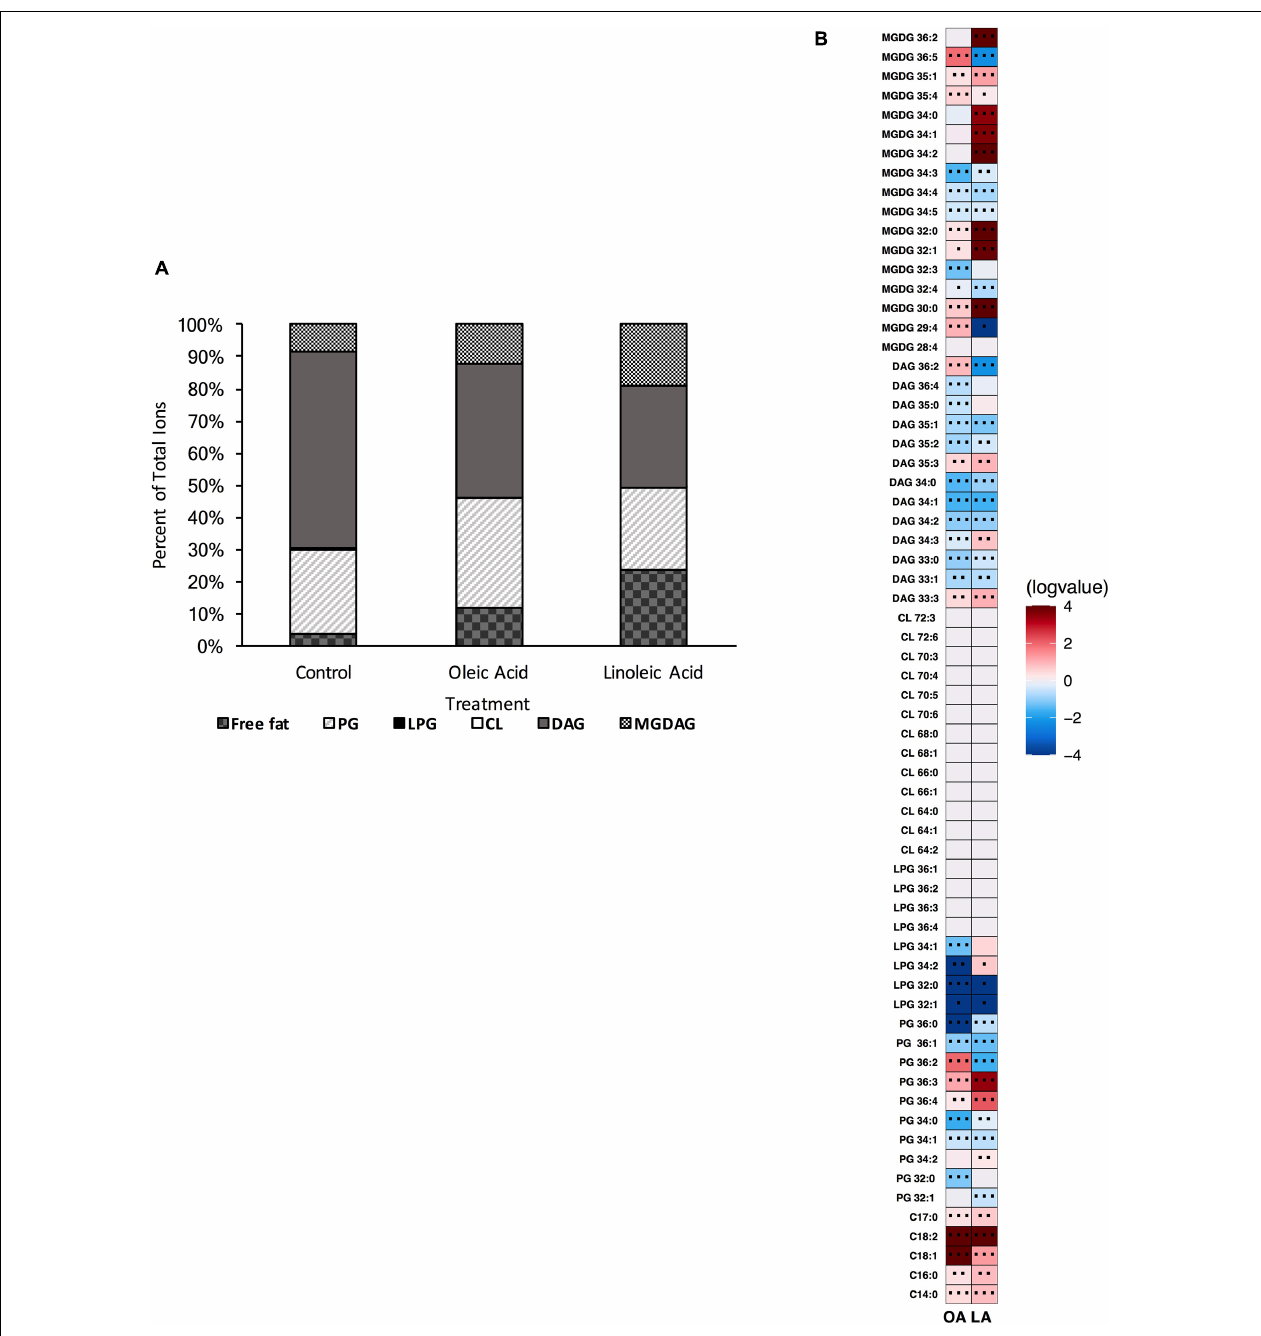
FIGURE 4 | A strain deleted for (cid:49) cls1/cls2 can alter its lipid composition upon exposure to host fatty acids. (A) Percent totals of lipid species in solvent control: free fatty acids (3.8%), PG (26.3%), L-PG (0.1%), CL (0.0%), DAG (61.3%), and MGDG (8.5%), oleic acid: free fatty acids (11.7%), PG (34.3%), L-PG (0.0%), CL 0.0%), DAG (41.5%), and MGDG (12.5%), linoleic acid: free fatty acids (23.4%), PG (25.7%), L-PG (0.2%), CL (0.0%), DAG (31.9%), and MGDG (19.0%). Species were normalized to OD 600 nm . (B) Heat-map of fold changes upon fatty acid supplementation vs. solvent control; OA, oleic acid supplementation; LA, linoleic acid supplementation. Shown are the average fold changes of those detected lipid species above limit of detection for n = 5 samples. * P = 0.1–0.05; ** P = 0.05–0.01; *** P <